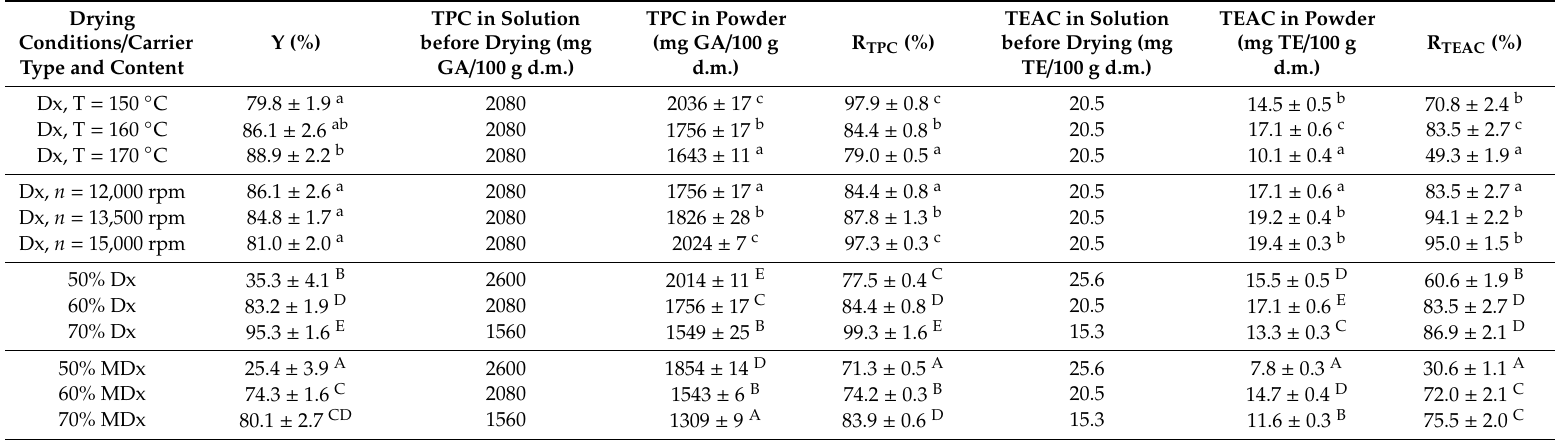
Table 3. Powder yield (Y), total polyphenol content (TPC) in solution before drying, total polyphenol content (TPC) and TPC retention (R TPC ) in spray-dried chokeberry powder, trolox equivalent antioxidant capacity (TEAC) in solution before drying, trolox equivalent antioxidant capacity (TEAC) and TEAC retention (R TEAC ) in spray-dried chokeberry